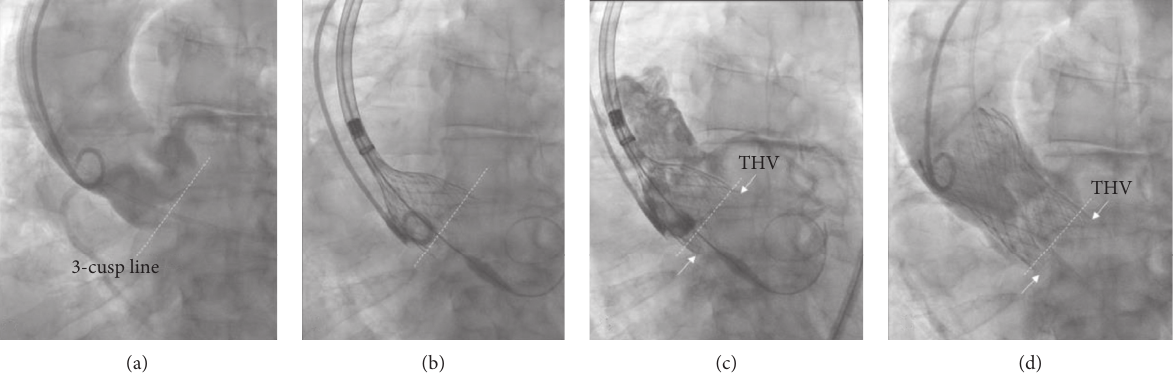
Figure 1: THV implantation in conventional 3-cusp coplanar view. (a) 3-cusp coplanar view (CON) in LAO projection. (b, c) THV positioning in the CON view. (d) Final angiographic outcome after using a standard 3-cusp coplanar projection (29mm Evolute R ™ THV). LAO � left anterior oblique, THV � transcatheter heart valve, CON � 3-cusp coplanar